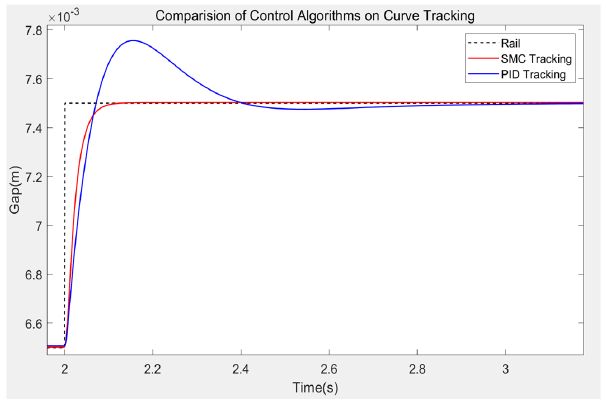
Figure 9. Partial enlarged view of curve tracking.